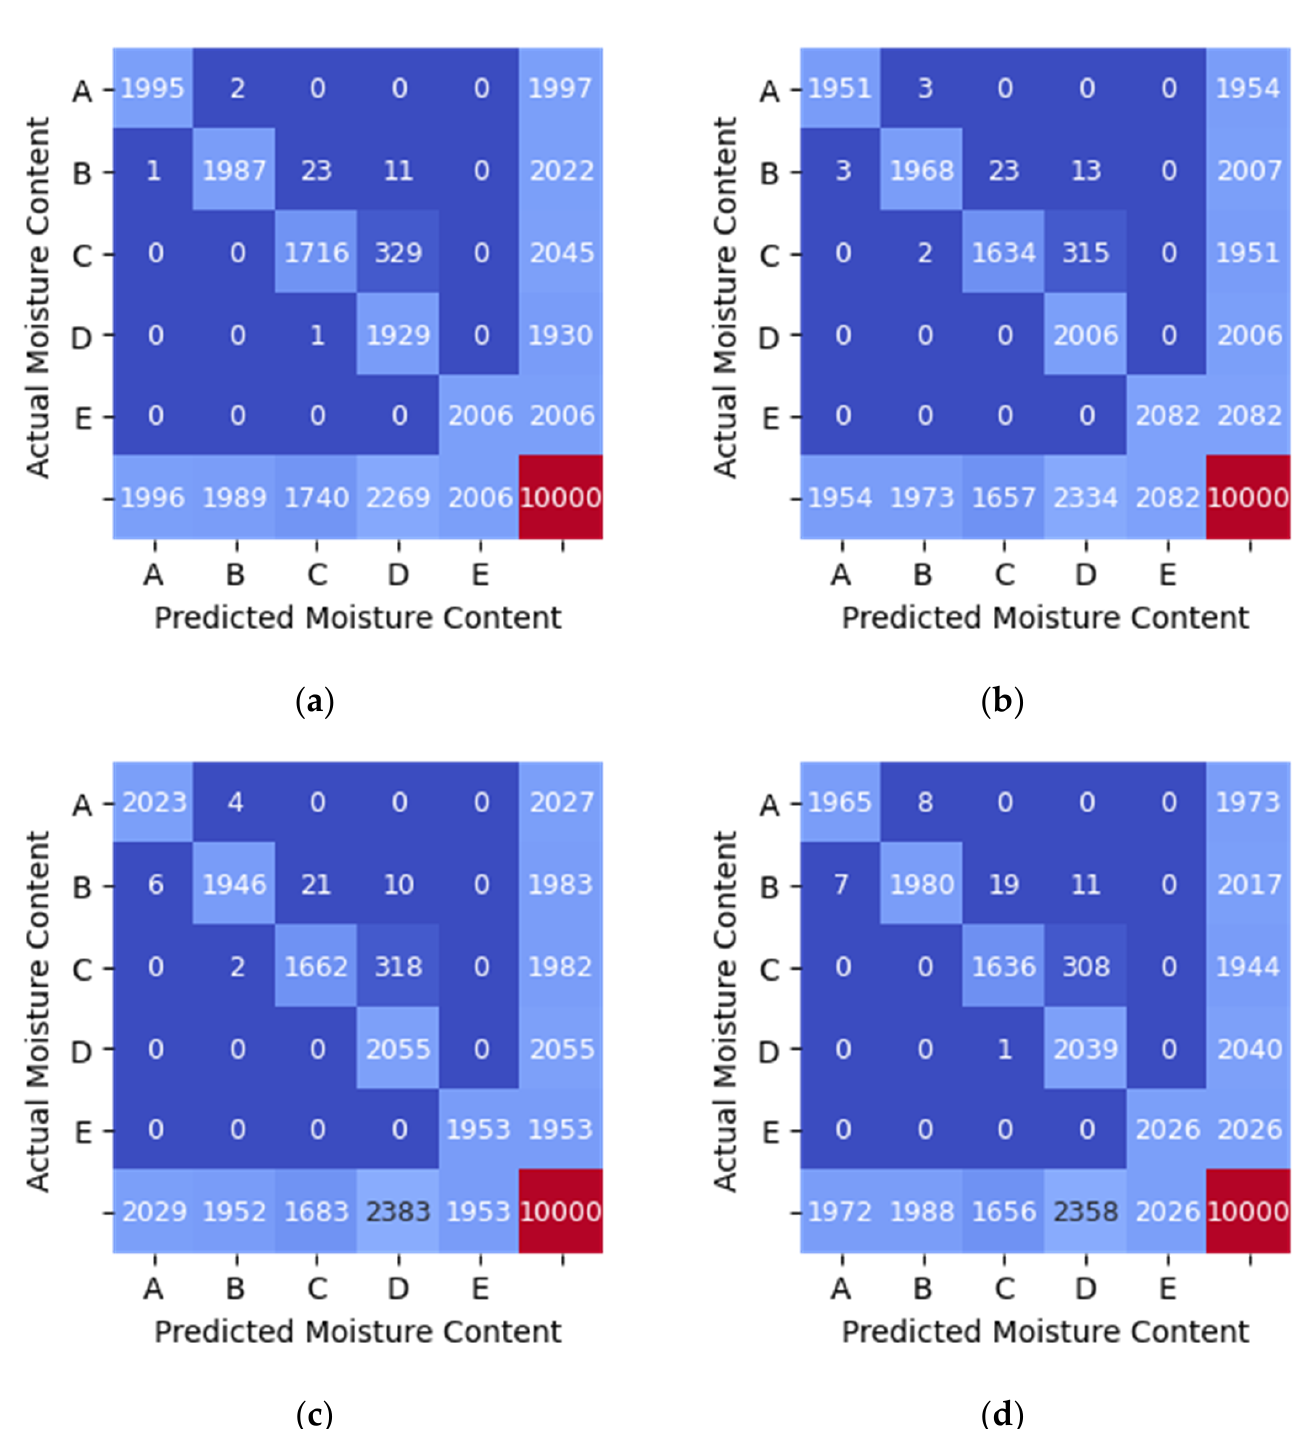
Figure 9. Confusion Matrix Heatmap of RSSI_TAG2 data. ( a ) SVM (linear kernel). ( b ) Random Forest. ( c ) KNN ( n = 5). ( d ) MLP.